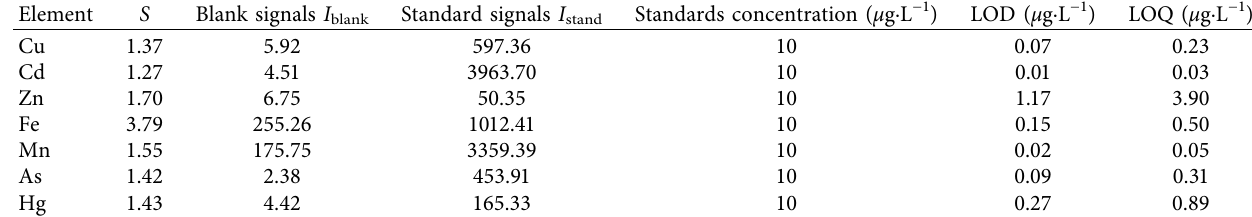
Table 3: LOD and LOQ values of analyzed trace metal elements by